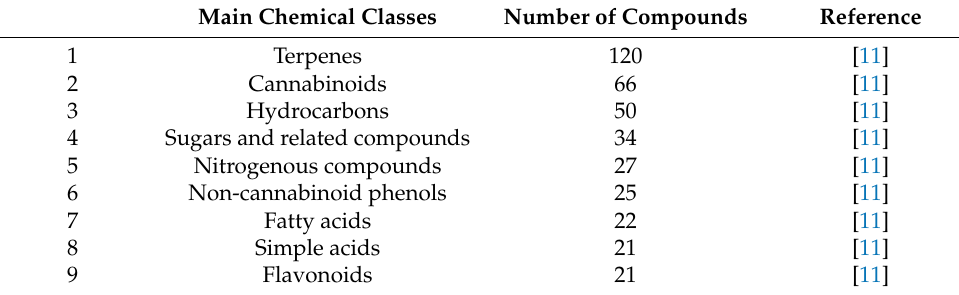
Table 1. The main biogenetic classes of compounds produced by Cannabis sativa L. [11]. Main Chemical Classes Number of Compounds Reference